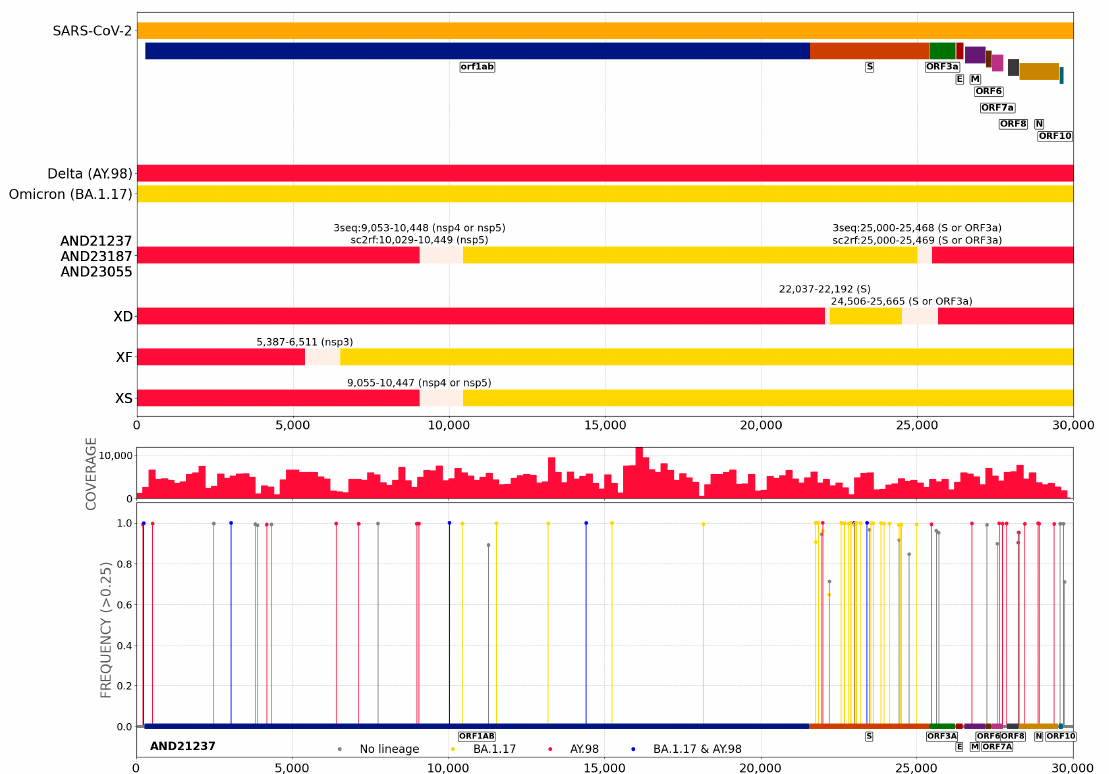
Figure 4. Novel Delta-omicron recombinant. Samples AND21237 and AND23187 (Illumina, San Diego, CA, USA, sequencing) and AND23055 (Oxford nanopore sequencing) correspond to the same patient (see Tables S1 and S3). 3seq outputs AY.98 and BA.1.17 lineages and their corresponding breakpoints. sc2rf outputs for Delta-BA.1 lineage with similar breakpoints to 3seq ones. A breakpoint interval (grey bar) spans between the lowest and the greatest position value of breakpoints provided by the two recombinant detection tools. Plots of distribution of mutations is also shown for AND21237 sample.